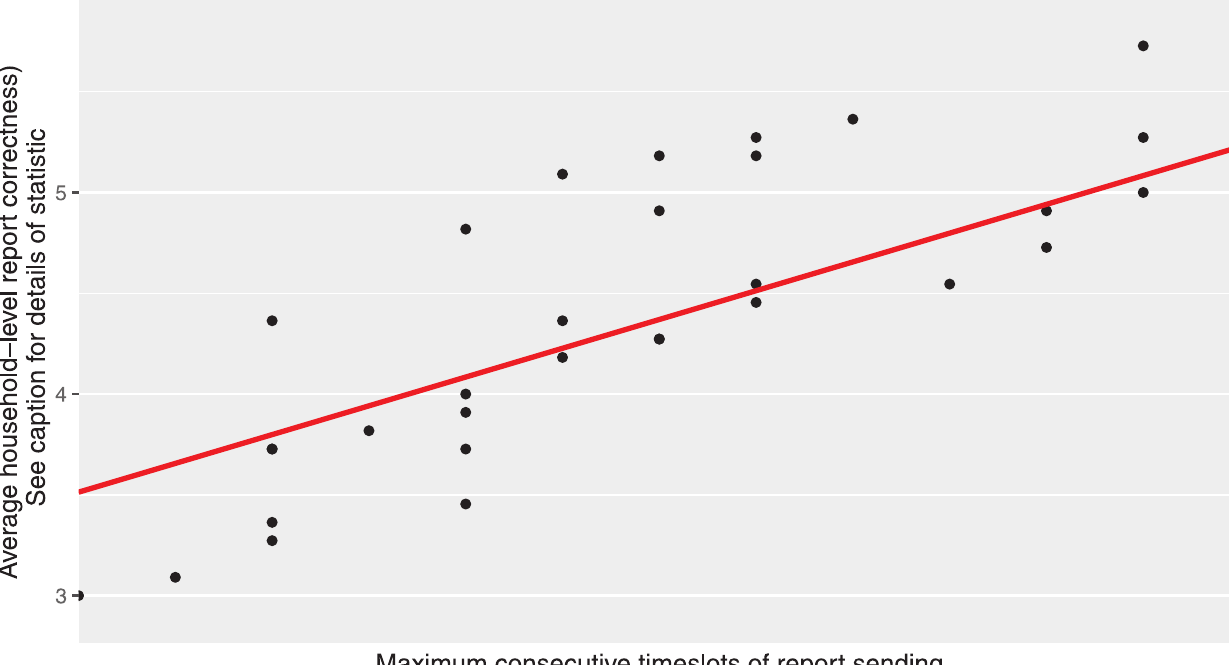
Fig 4. Household-level reporting consistency. Descriptive statistics pertaining to household responsiveness. Consecutive reporting is determined on the basis of receiving at least one report at the household-level, correct or incorrect ( 4a ). Also considered is the relationship between overall reporting consistency and average report accuracy ( 4b ). The statistic used for household-level correctness is derived from the 12 timeslot average of coding household report behaviour as follows: No reports = 1; one report, incorrect = 2; one report, correct = 3; two incorrect = 4; two reports, one incorrect = 5; two reports, correct =